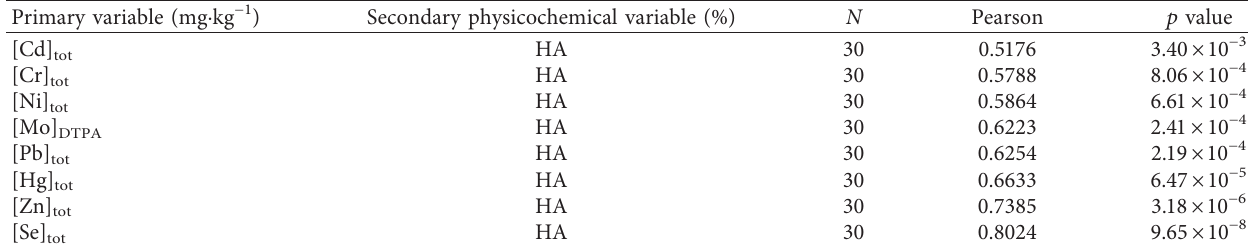
Table 8: Positive values of Pearson’s correlation between primary variables and the AH with significance without influence of the in- oculation